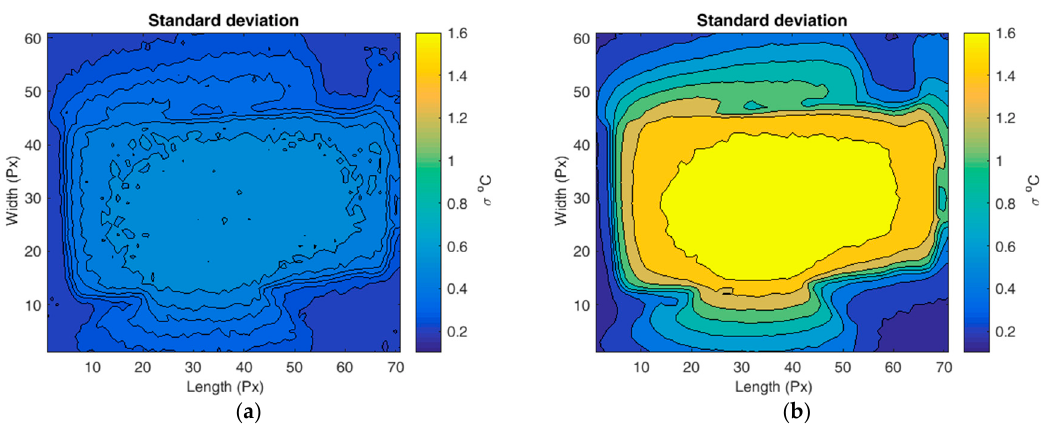
Figure 16. Graphic display of standard deviation changes for: ( a ) test parameters U = 2.7 V and I = 500 mA; ( b ) test parameters U = 2.7 V and current I = 1400 mA.